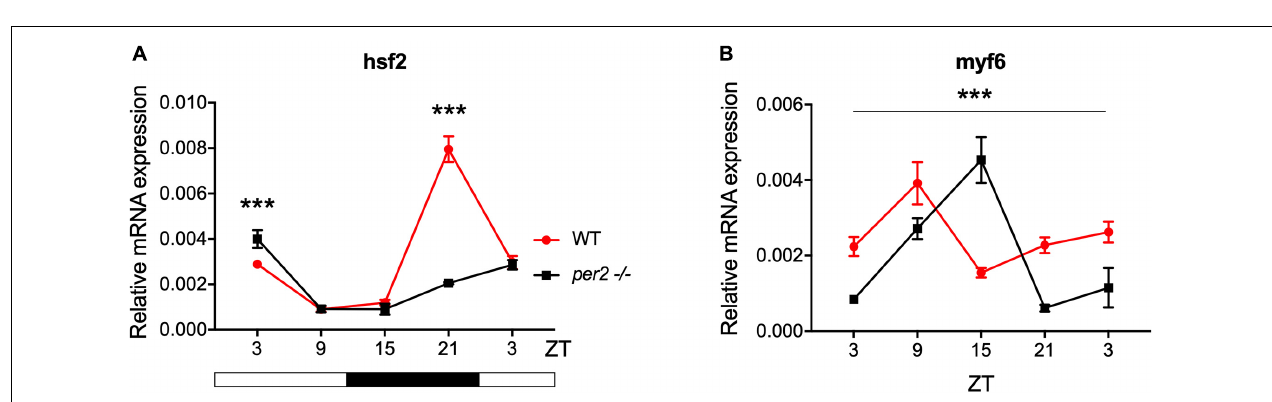
FIGURE 7 | Per2 knockout alters the rhythmic mRNA expression of CCGs encoding key enzymes in non-essential amino acid synthesis in the adult zebrafish liver. qRT-PCR analysis of expression levels of six CCGs (A) glu1a , (B) asns , (C) gpt2l (D) glud1b (E) got1, and (F) got2a in WT and per2 KO liver tissues as described in the legend for Figure 6 . A change in rhythm was observed for all genes, as determined by a significant ANOVA Genotype × Time interaction effect for all genes ( p < 0.001, see Table 1 ). Asterisks represent levels of significance in comparing the two genotypes at each time point individually, corrected by Sidak’s method (*** p < 0.001, ** p < 0.01, * p < 0.05).